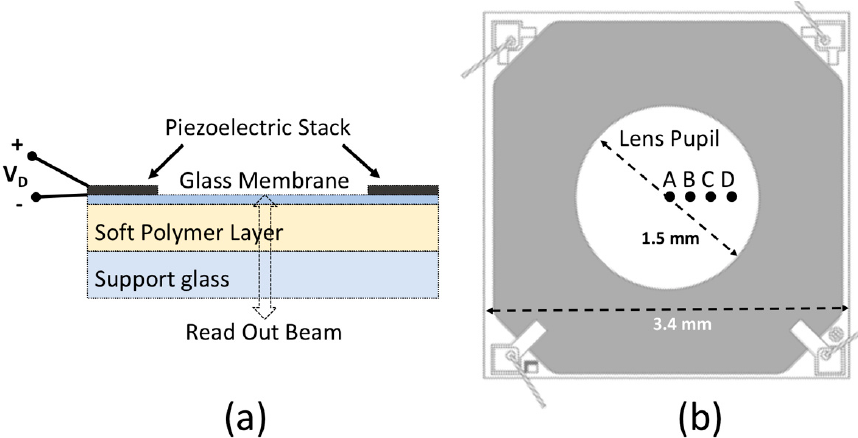
Figure 1. ( a ) Cross-sectional schematic structure of the Tlens ® in quiescent conditions. ( b ) Top view of the device showing the four radial positions (A, B, C, D) where measurements were performed. Sketches are not in scale.